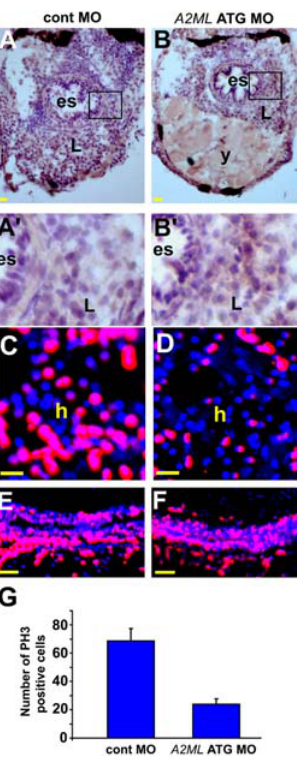
Figure 6. TUNEL and PH3 staining in A2ML ATG MO-injected embryos. All embryos were at 5 dpf. A–D are transverse section, and E–F sagital section. A–B 9 TUNEL staining of cont MO-injected embryo (A), and knock-down embryo (B). Areas in open square in A and B are magnified in the A 9 and B 9 . C–D Confocal images of sections stained with anti-PH3 ser10 antibody. E–F PH3 staining in the intestine in cont MO (E) and in A2ML ATG MO-injected embryos (F). G Quantification of PH3-positive liver cells. Scale bars in (A and B) 20 m m, and in (C–F) 50 m m. es, esophagus; L, liver; y, yolk.